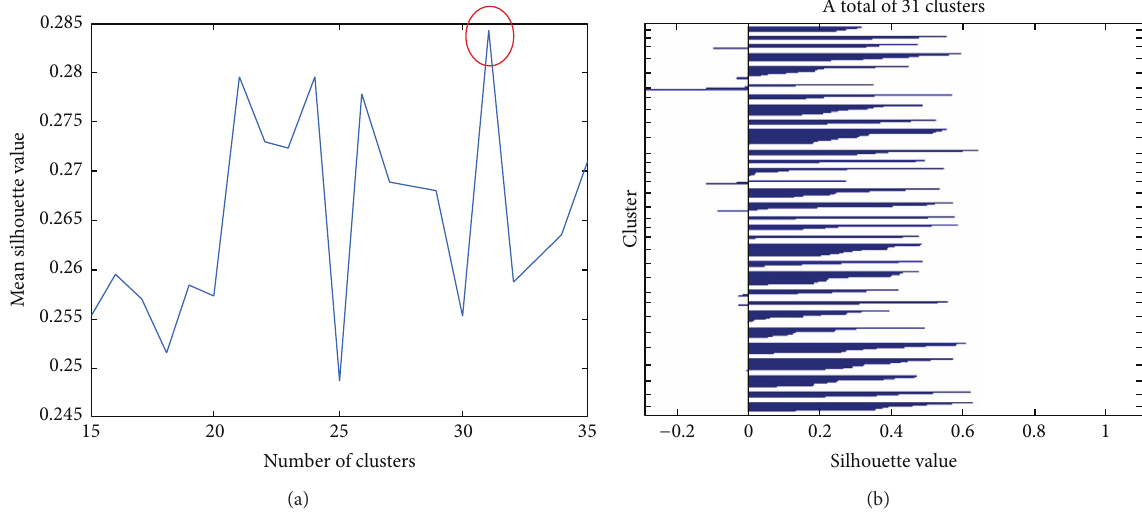
Figure 4: (a) Choice of clusters numbers and (b) silhouette value for 31 clusters.